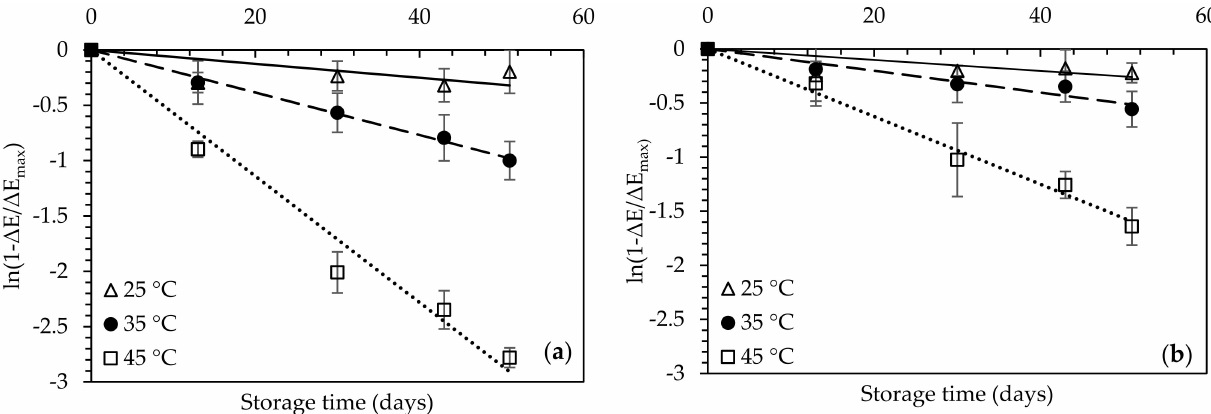
• ) and 45 ◦ C ( (cid:3) )) on the